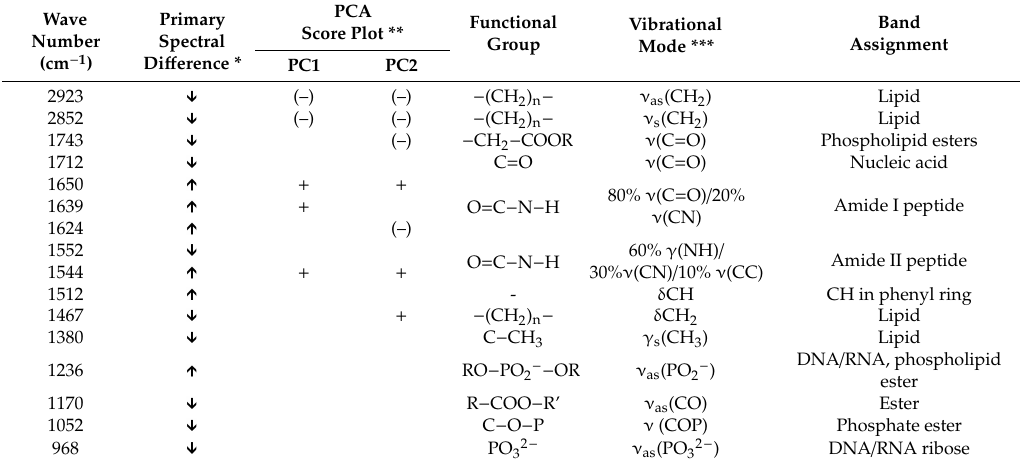
Figure 3. Average second derivative spectra ( 9 points smoothed with EMSC normalized ) in the (A) lipid ( 3000 – 2800 cm − 1 ) , (B) protein ( 1700 – 1450 cm − 1 ) , and (C) nucleic acid ( 1280 – 900 cm − 1 ) regions of decontaminated ( 67 spectra from triplicate samples ) and contaminated ( 58 spectra from triplicate samples ) HepG2 cells . Table 2. FTIR bands of the mycoplasma-contaminated HepG2 cells compared to decontaminated HepG2 cells and their assignments